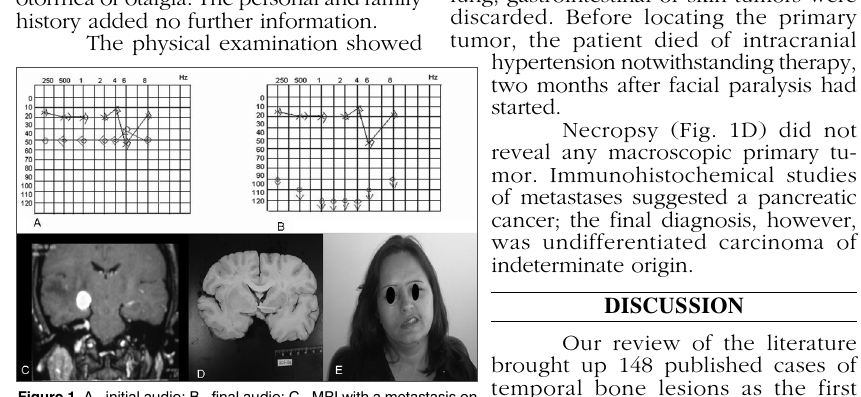
Figure 1. A - initial audio; B - final audio; C - MRI with a metastasis on the MAI; D - necropsy result; E - facial paralysis G V to the